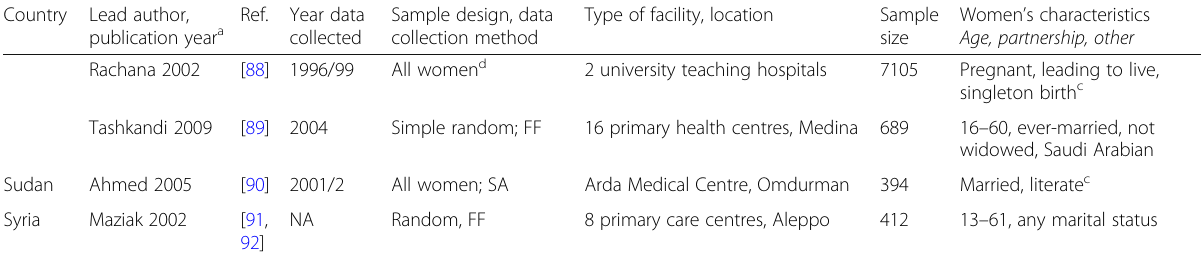
Table 3 Characteristics of facility-based IPV studies reported in peer-reviewed journal articles (Continued) Country Lead author, Ref. Year data publication year a